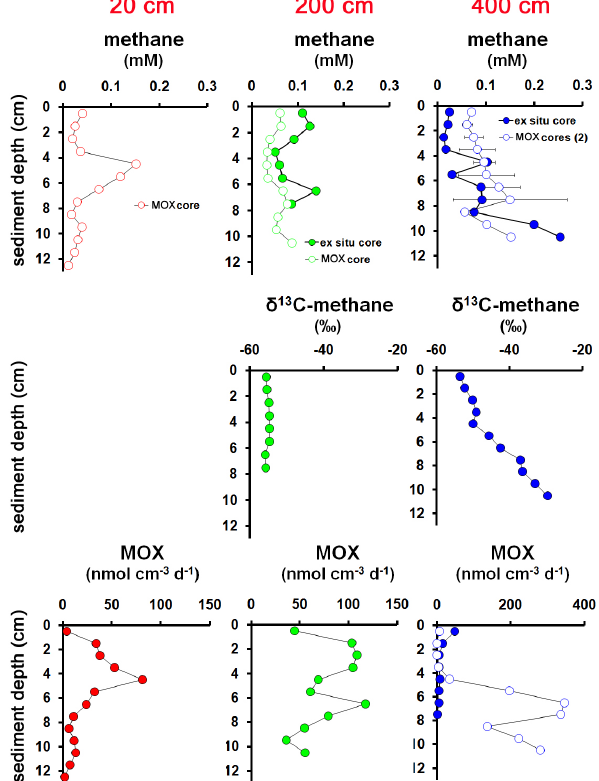
Fig. 1b. Biogeochemical profiles of the April sampling (transect) at Brian Seep: methane, δ 13 C-methane, and methane oxidation (MOX, 2 replicates). Methane profiles show methane concentra- tions of samples taken immediately after recovery (ex-situ core) or after 24h incubation (MOX cores, no. of replicates provided in leg- end, S.D. bars are given). Methane concentrations are presented in mmol L − 1 sediment. Samples were available from 20 (red), 200 (green), and 400cm (blue) distance from the gas